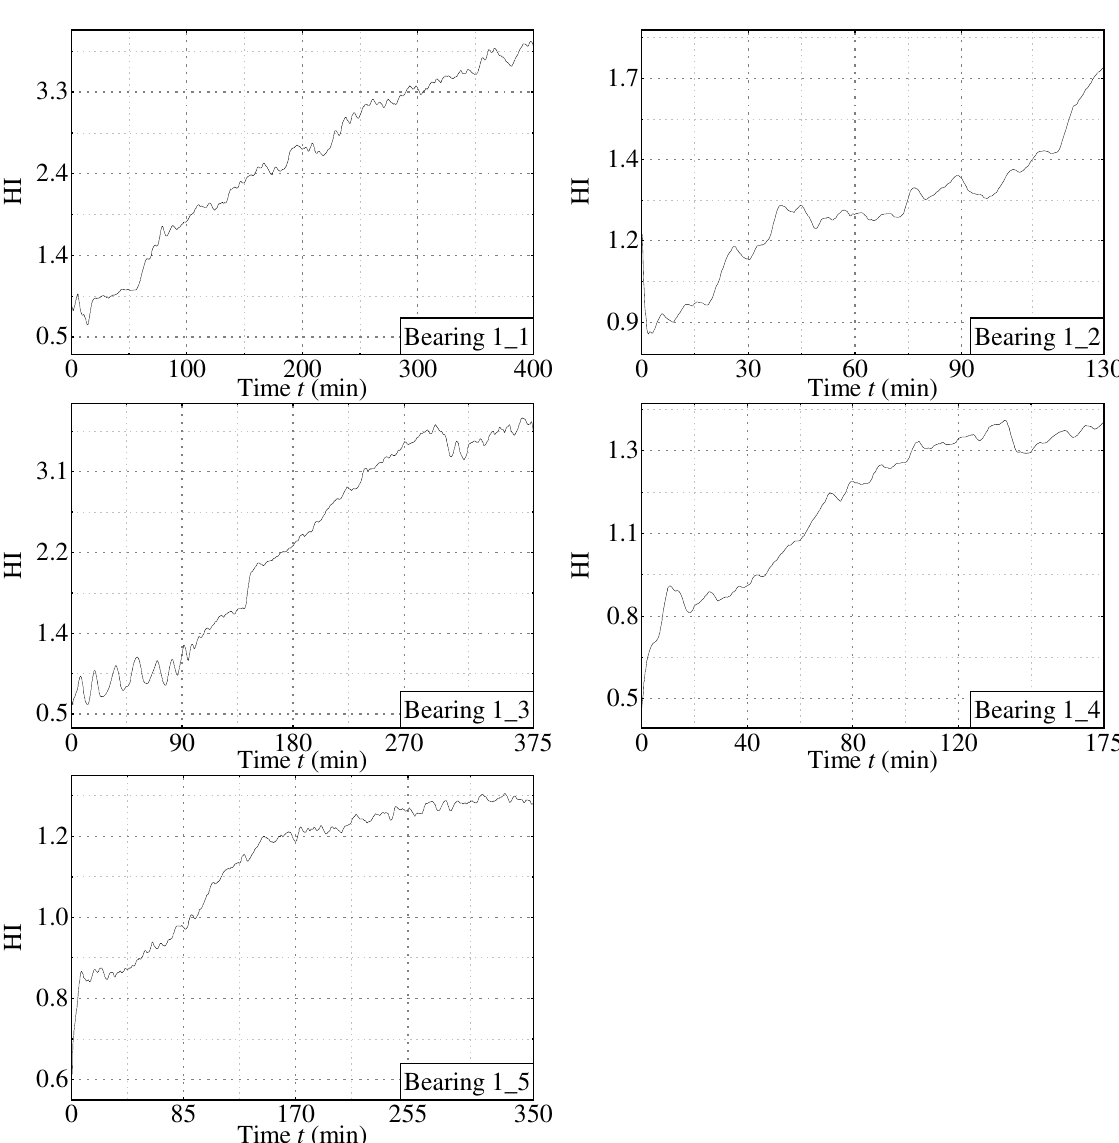
Figure 18. HI curves of the testing bearings.